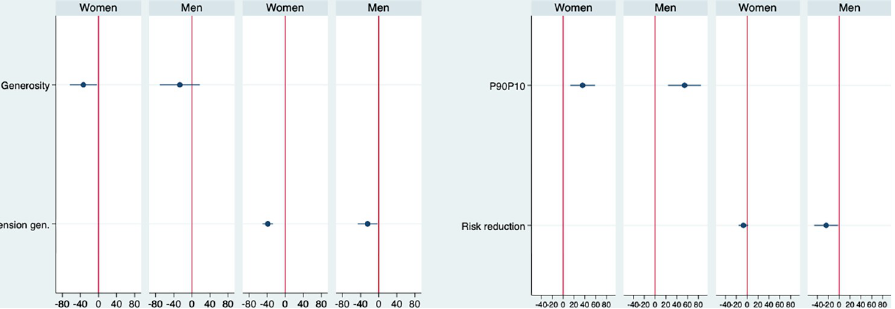
Fig 3. Long run multipliers of the standardized coefficients of the main variables on death rates, based on models from Tables 1 and